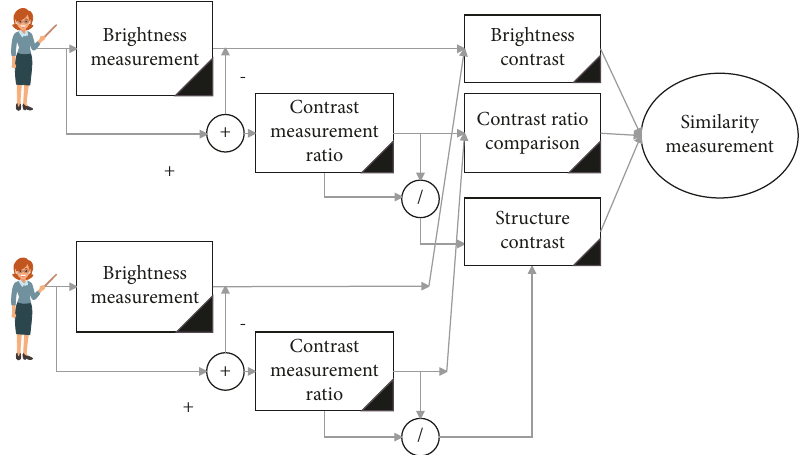
Figure 5: Schematic diagram of similarity measurement of English teaching images.